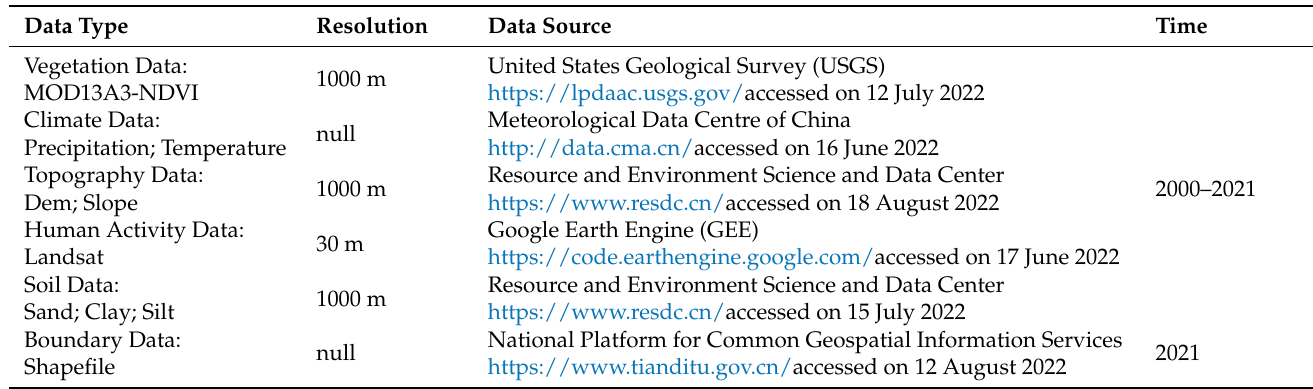
Table 1. Data types and data sources.